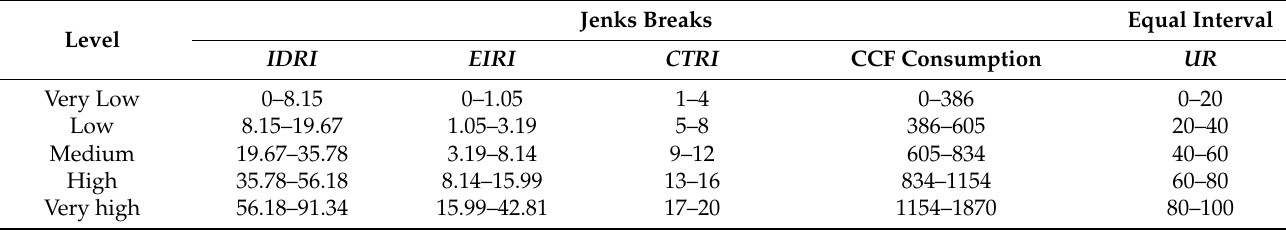
Table 2. Criteria for classification of different